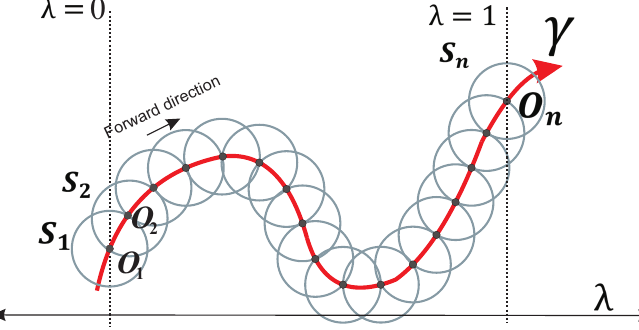
Figure 3. 2-D representation of spherical tracking algorithm process.